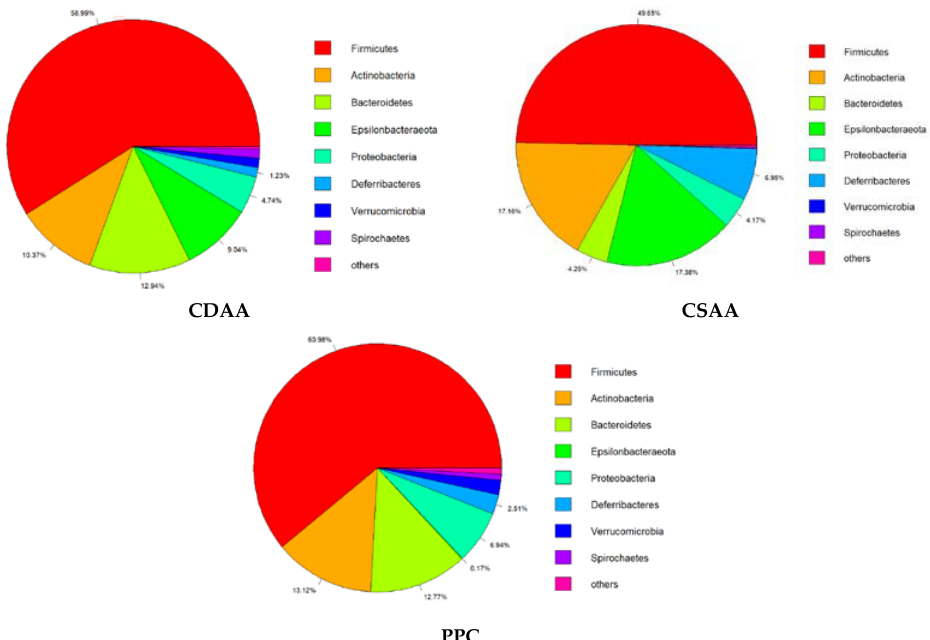
Figure 8. Average phylum distribution of gut microbiomes for CDAA, CSAA, and PPC groups.